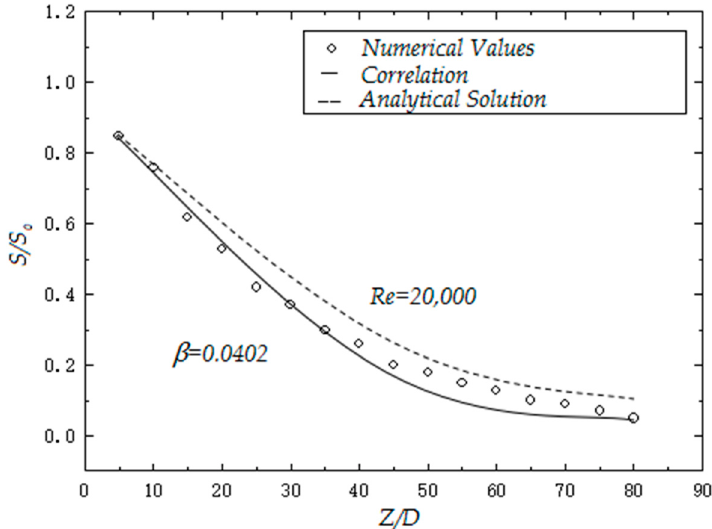
Figure 10. Comparison of numerical simulations with the results of the dimensionless swirl number in the literature.